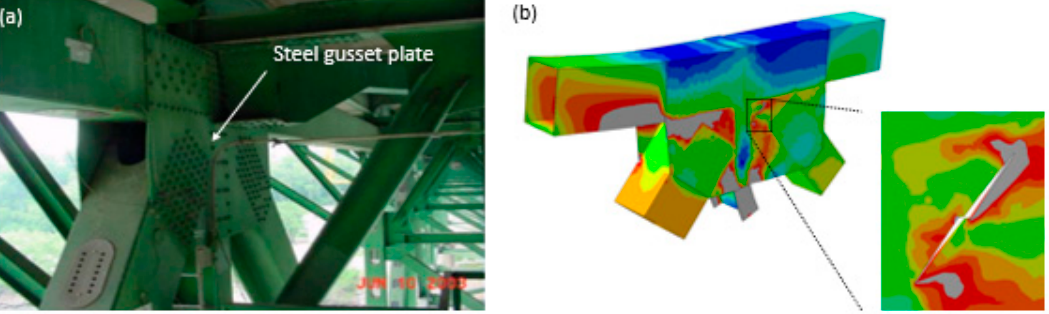
Figure 6. ( a ) A gusset plate structure, ( b ) finite element (FE) model of the failed gusset plate [15,73,74].